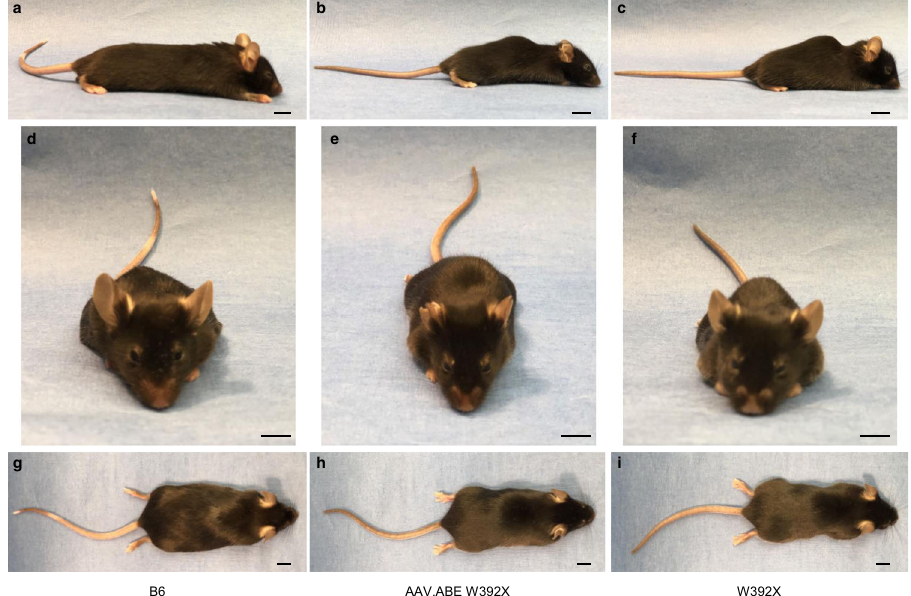
Fig. 6 In utero base editing ameliorates the facial and skeletal abnormalities in Idua-W392X mice. a – i Representative photographs of 6-month-old female B6 mice ( a , d , g ), Idua- W392X mice prenatally treated with AAV.ABE.Idua ( b , e , h ), and untreated Idua- W392X mice ( c , f , i ). Scale bar = 1